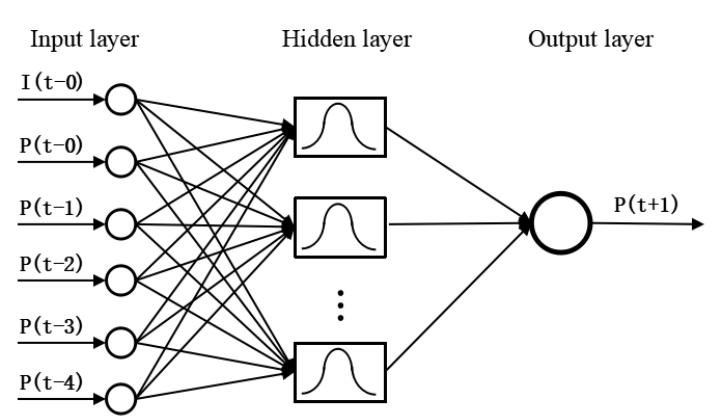
Figure 5. RBF neural network for PV forecasting model